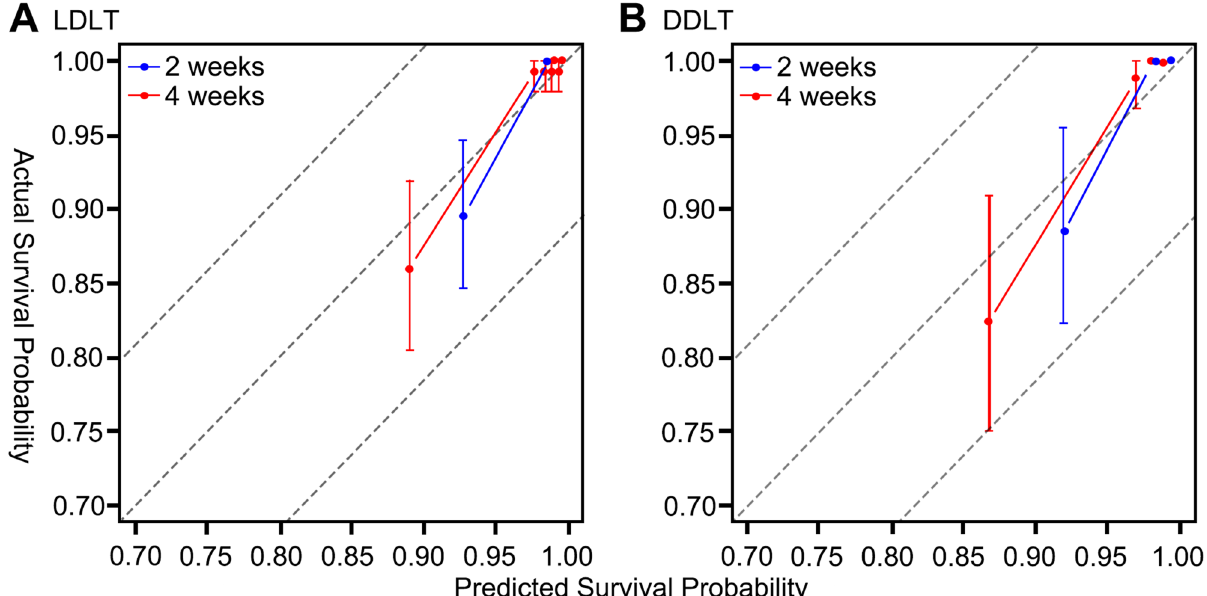
Figure 2. Calibration plots of ABC models for predicting graft survival within 2 weeks and 4 weeks ( A ) in LDLT cases ( B ) and DDLT